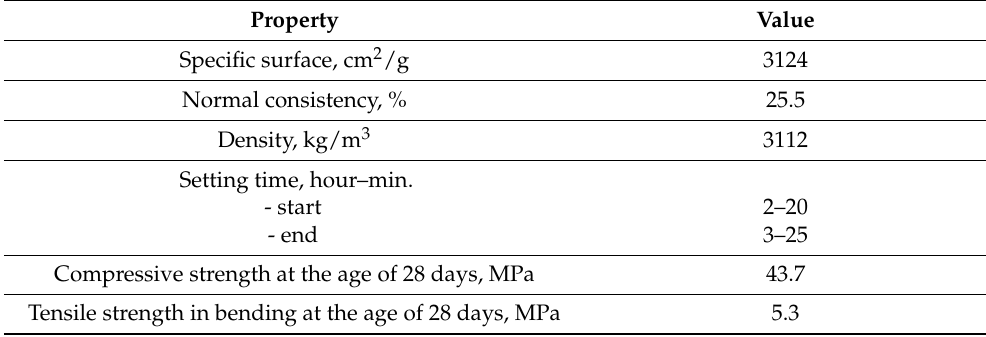
Table 1. Properties of Portland cement.